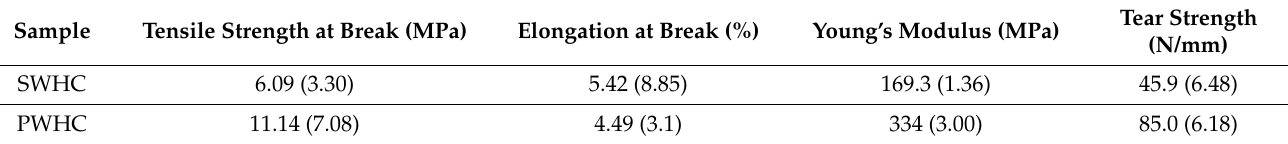
Table 4. Moisture content and hardness of the PWHC and SWHC.